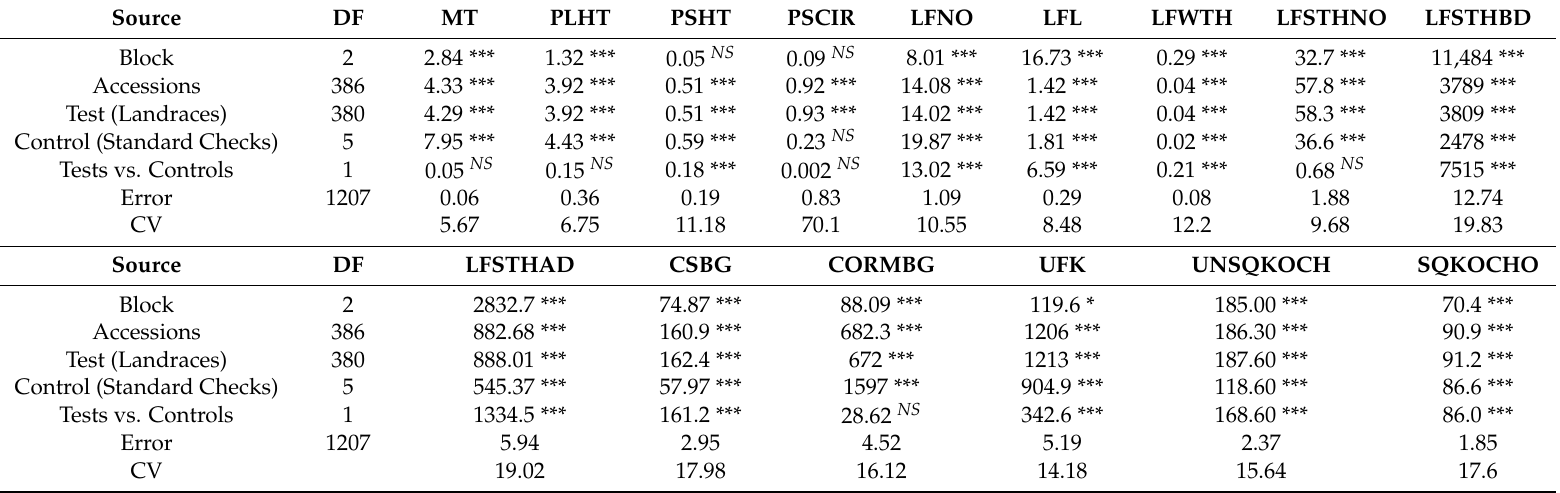
Table 1. Analysis of variance of 15 quantitative